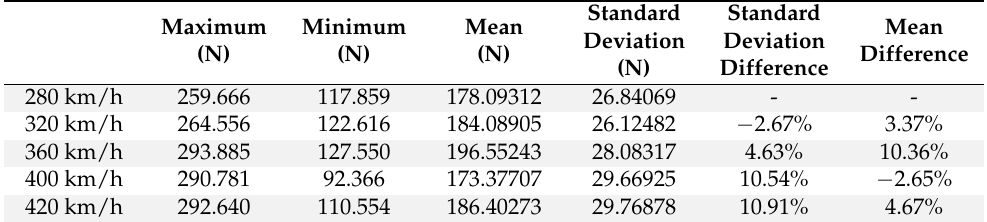
Figure 12. Comparison curves of contact force between pantograph and catenary passing through tunnel at different speeds. Table 3. Statistical results of contact force between pantograph and catenary passing through tunnel at different